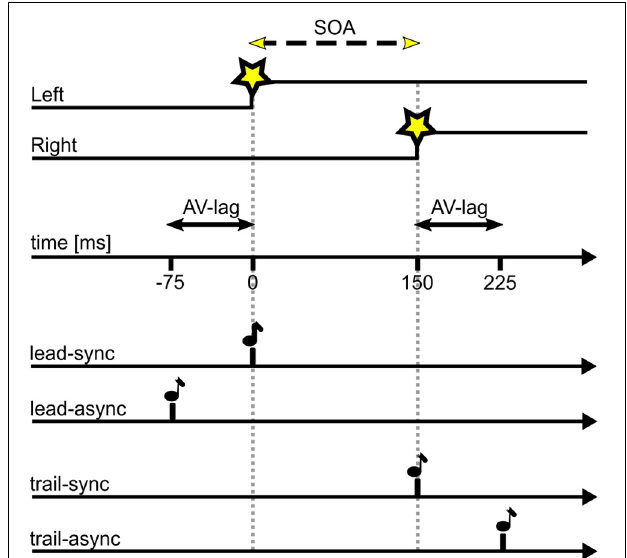
FIGURE 1 | Timing of stimuli as presented in this study. SOA of variable duration as indicated by the dashed line, in this example SOA = 150 ms with left LED first; AV-lag of 75 ms. Star symbol, LED onset; note symbol, acoustic stimulus. A test trial consists of the visual stimulus (upper two traces) presented together with one of the four acoustic stimuli (lower four